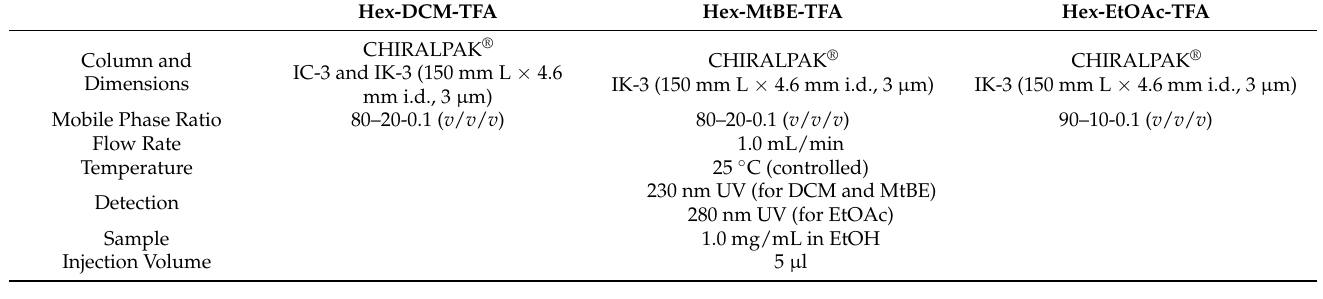
Table 3. Summary of analytical screening results yielding separations for CBCA and CBLA.